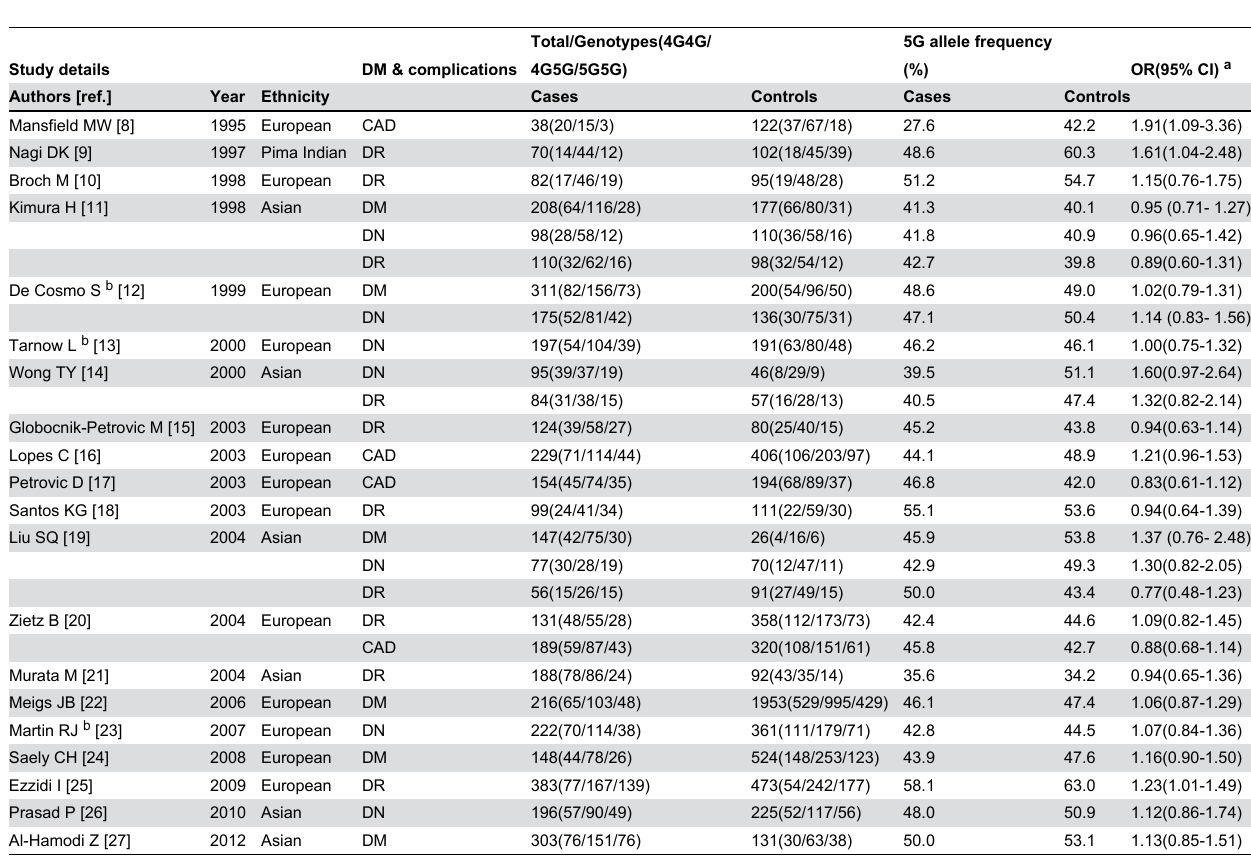
Table 1. Characteristics of the PAI-1 -675 4G/5G polymorphism allelic and genotype distribution for diabetes and diabetic complications risk in studies included in the